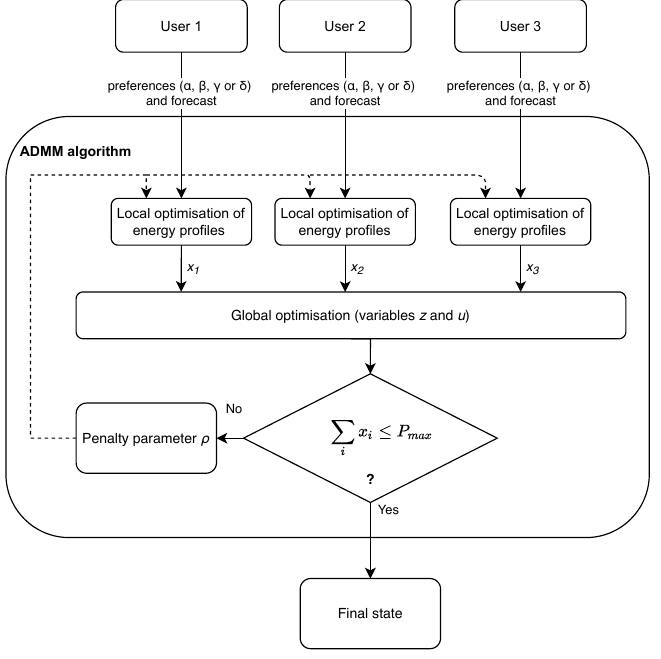
Figure 1. Distributed optimisation